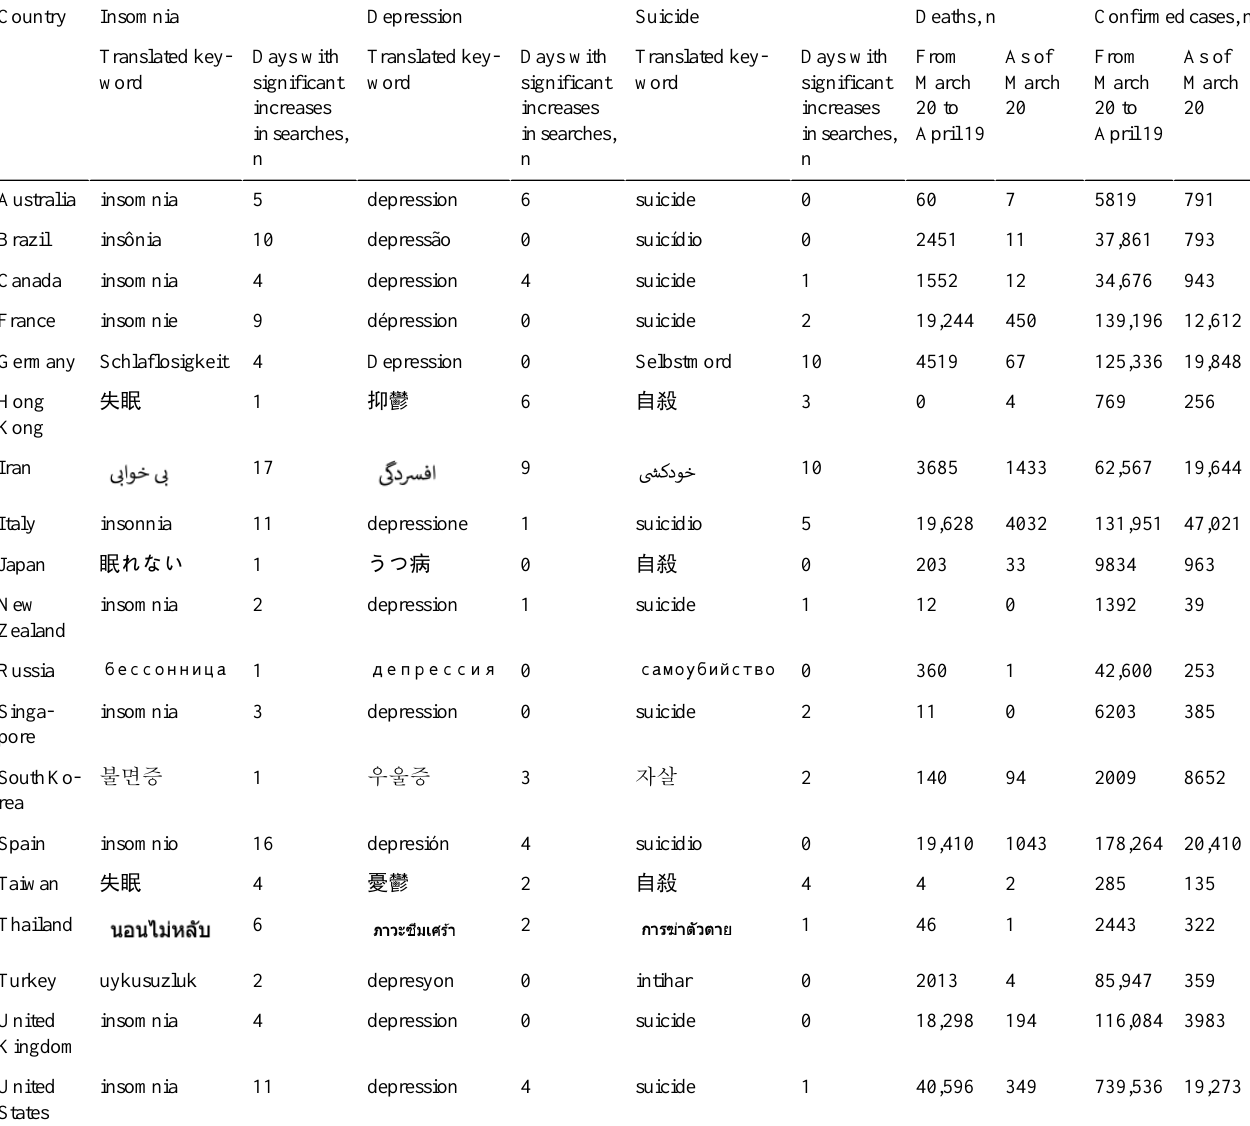
Table 1. Number of days with significant increases in searches for insomnia, depression, and suicide in each country’s local language, as well as the cumulative number of confirmed cases as of March 20, 2020; increases in confirmed cases from March 20 to April 19; and the increases in the number of deaths due to